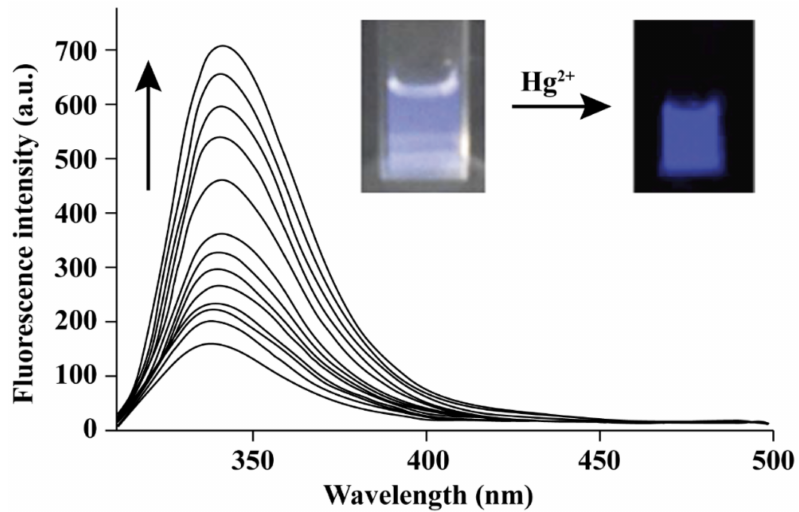
Figure 5. Graph manifesting the change in emission of ligand 1 upon gradual addition of Hg 2+ ion at 336 nm. Inset shows the switch-on fluorescence upon interaction of chemosensor with Hg 2+ ion (re-drawn from [22]).